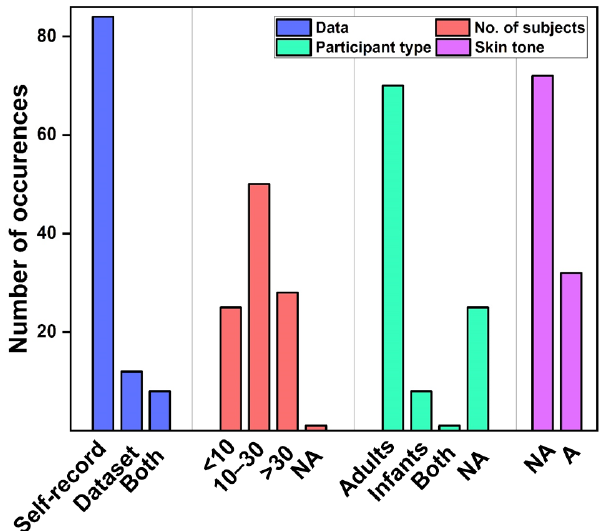
Figure 4. Distribution of subject information including obtained data, number of subjects, participant type and available (A) and not available (NA) info of skin